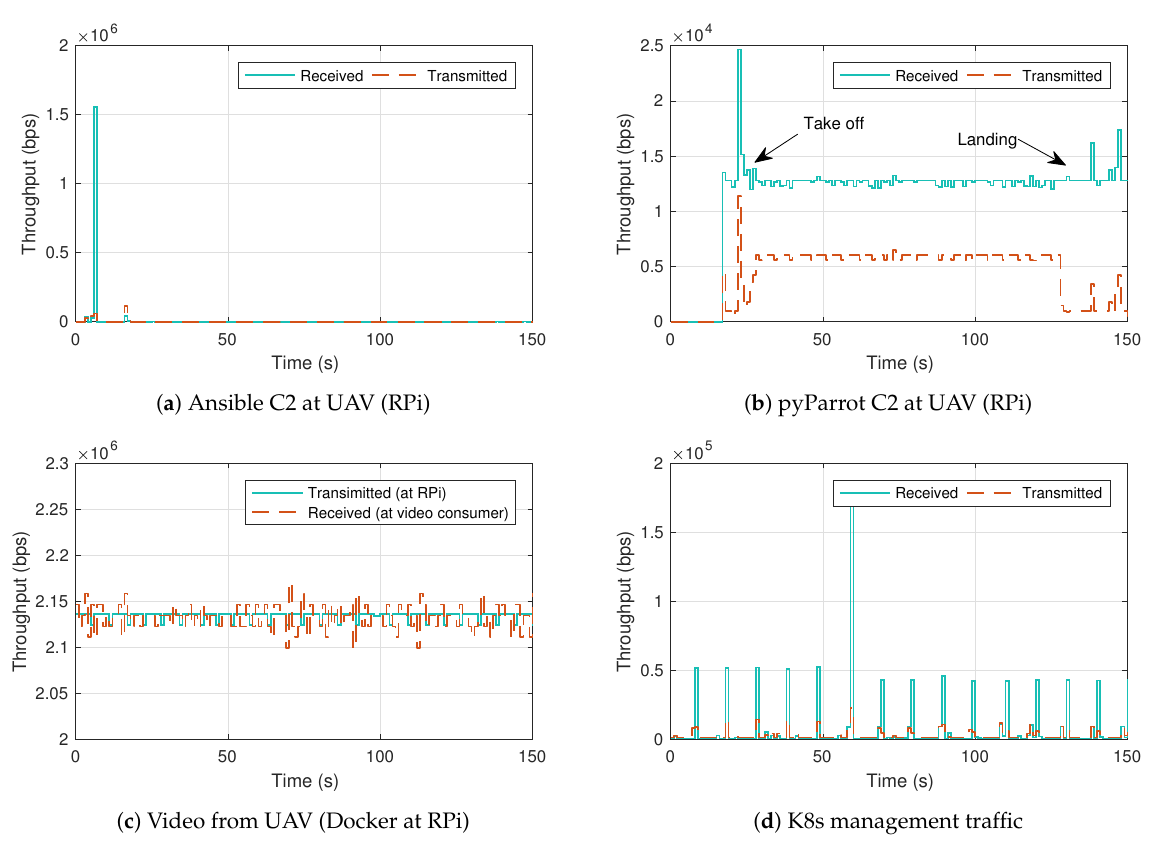
Figure 6. Measurements in indoor